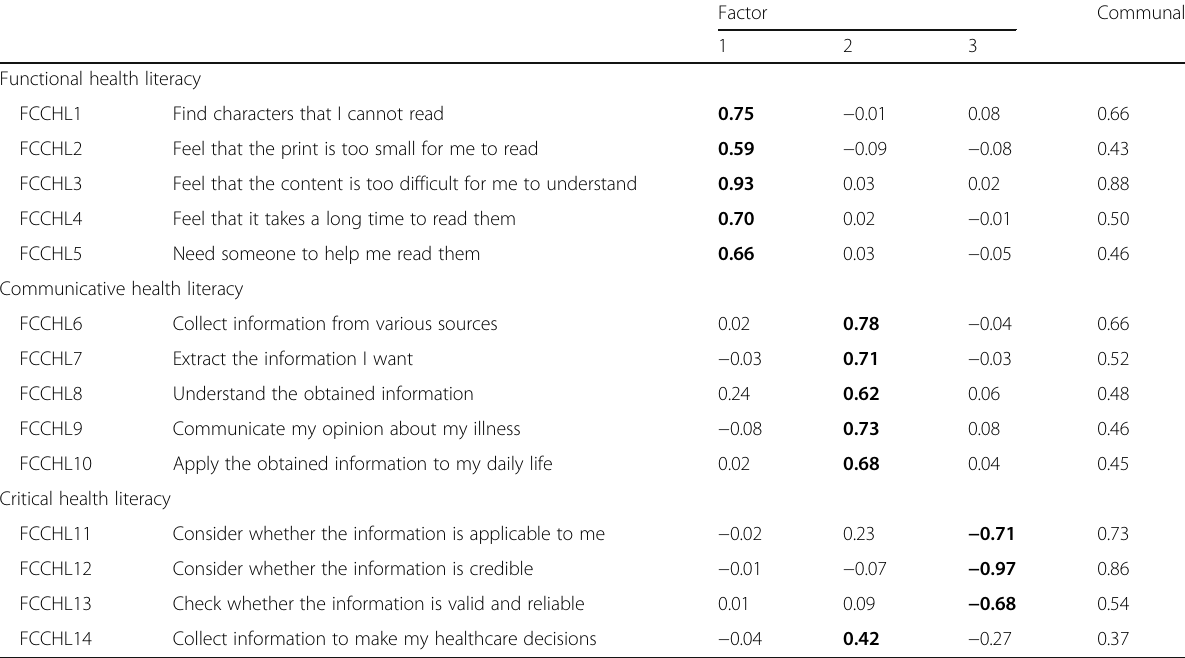
Table 2 Factor structure of the FCCHL scale. ( n = 781, Training sample)